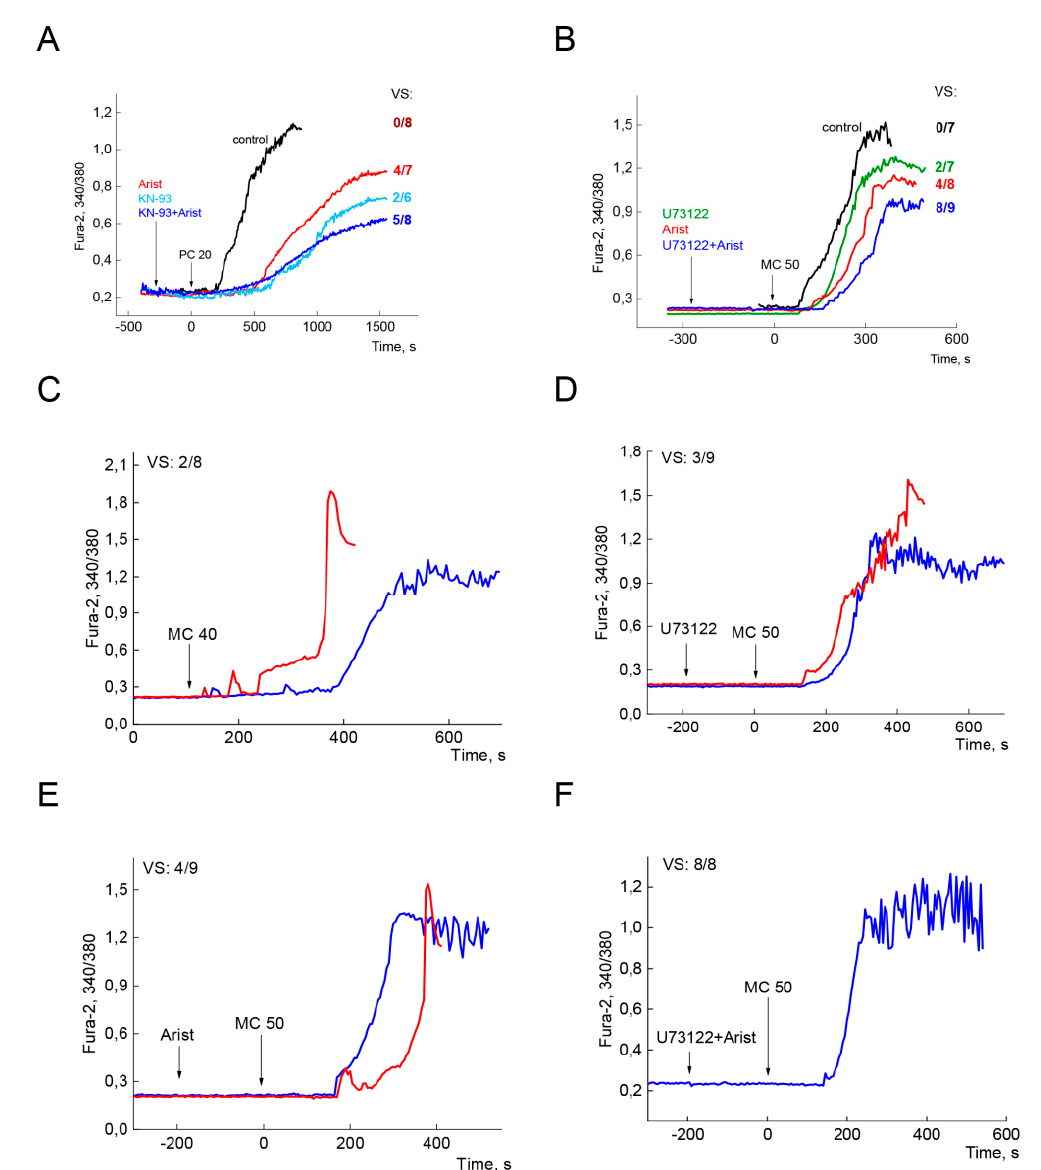
Figure 7. Implication of phospholipases and CaMKII in Ca 2+ overload and myocytes death. Panel ( A ). Separate and combined effects of aristolochic acid (Arist, 100 µM) and KN93 (20 µM), inhibitors of PLA2 and CaMKII, respectively, on Ca 2+ overload and CM death/viability at 20 µM PC. Viability score (VS) is the ratio of viable to total cells ( n ) in the plate. Average values are depicted for all dead cells in control (black line, VS = 0/8, n = 8) and all viable cells for traces with the inhibitors (colored lines). For Arist, KN93, and Arist + KN93 viability score VS = 4/7, 2/6, and 5/8, respectively. n = 7, 6, and 8. Panel ( B ). Separate and combined effects of U73122 (10 µM), inhibitors of PLC, and Arist, on Ca 2+ overload and CM death/survival at 50 µM MC. Average values are depicted for all dead cells in control (black line, VS = 0/7, n = 7) and all viable cells for traces with the inhibitors (colored lines). For U73122, Arist, and U73122 + Arist viability score VS = 2/7, 4/8, and 8/9, respectively. n = 7, 8, and 9. All displayed graphs are representative of 3 independent experiments. Panels ( C – F ) depict representative traces characterizing dying cells (C, red traces) and viable cells (dark blue traces) in the populations of cells predisposed to Ca 2+ oscillations and partially resistant to MC or PC excess. Panel ( C ) depicts control experiment with 50 µM MC (VS = 2/8, n = 8). Separate and combined effects of U73122 and Arist are presented in panels ( D – F ). Here, VS = 3/9, 4/7, and 8/8, respectively. n = 9,7, and 8, respectively. Traces presented at the panels depict of 1 of 3 independent experiments.